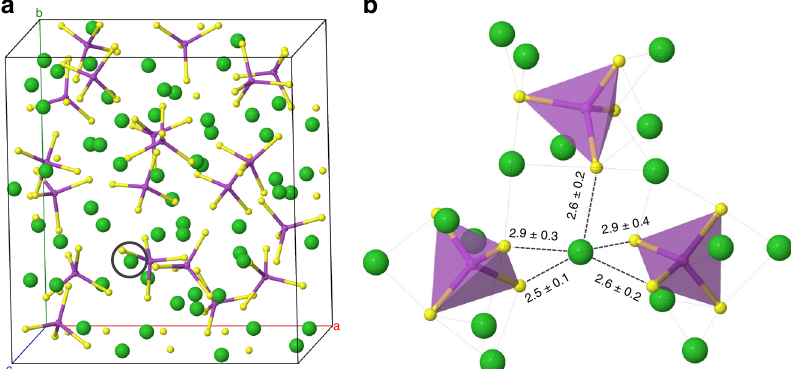
Fig. 1 Computed structure of glassy Li 3 PS 4 at 300K and 1 bar generated from melt-and-quench ab initio MD. Green spheres represent lithium ions, phosphorus is magenta, and sulfur is yellow. a Computational cell. A representative Li ion is identi fi ed with a black circle. The local solvation shell of this ion is magni fi ed in ( b ), where numbers indicate the mean and standard deviation of nearest-neighbor sulfur distances in Å, averaged over 10 ps of